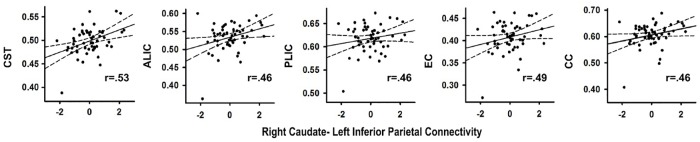
Association between abnormal context-dependent connectivity of the right caudate - left inferior parietal cortex and fractional anisotropy (FA) in underlying tracks in the PD group. The x axis plots the standardized residuals (adjusted for sex) for right caudate-left inferior parietal cortex connectivity. The y axis plots FA values (adjusted for sex during data post-processing) in bilateral white matter tracks. Solid lines show the best-fitting linear regression line and dashed lines represent the 95% confidence intervals. Pearson correlation coefficients are displayed in the lower right corner of each scatter plot. ALIC, anterior limb of the internal capsule; CC, body of the corpus callosum; CST, corticospinal tract; EC, external capsule; PLIC, posterior limb internal capsule.